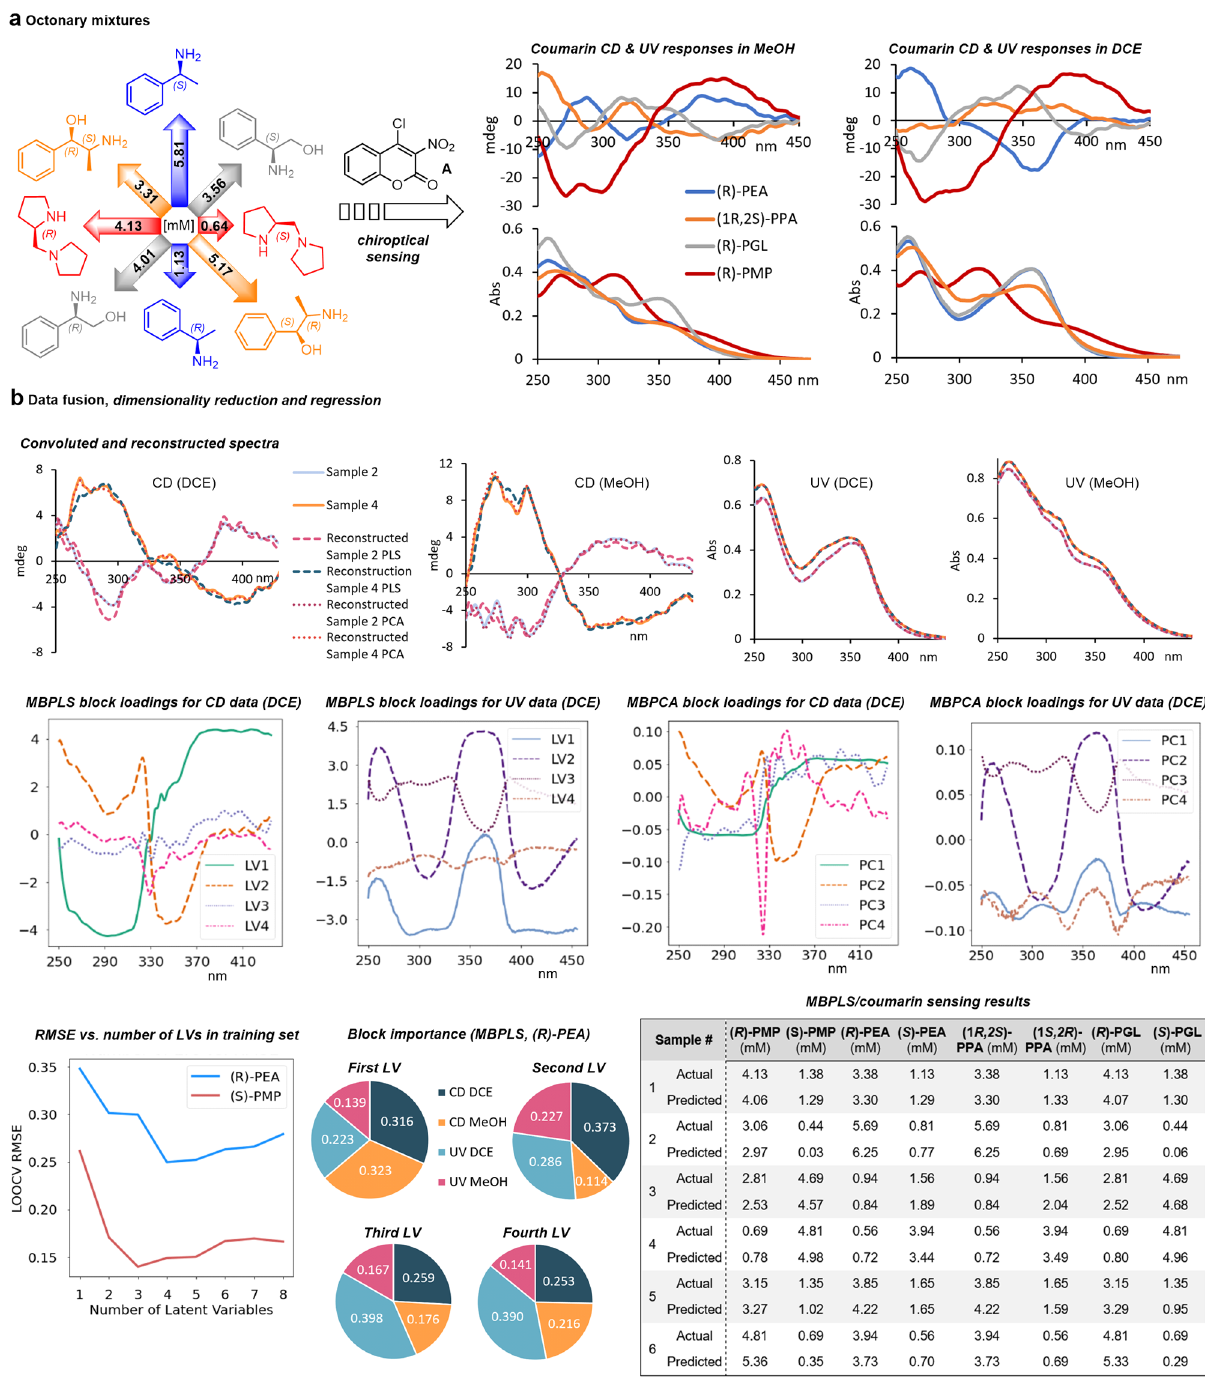
Fig. 5 Multi-modal optical chirality sensing of octonary samples. a Representation of a complex octonary chiral compound mixture and individual coumarin UV/CD responses for each chiral analyte in MeOH and DCE. b Top: The convoluted UV and CD spectra of fi ve samples were subjected to PCA and PLS analysis and the reconstituted spectra were generated using inverse transformation. Results with two samples are shown. Middle: Representative MBPCA and MBPLS block loadings for CD and UV spectra in DCE for ( R )- PEA . Bottom: Averaged LOOCV RMSE of the training sets vs. number of latent variables for ( R )- PEA and ( S )- PMP . The pie charts display the MBPLS block importance of 4 latent variables for ( R )- PEA . The table shows the comparison of the octonary sensing results obtained with MBPLS for six test samples and the actual concentrations. PEA : 1-phenylethylamine, PMP : 1-(pyrrolidin-2- ylmethyl)pyrrolidine, PGL : phenylglycinol, PPA : 2-amino-1-phenylpropan-1-ol. MBPCA multiblock principal component analysis, MBPLS multiblock partial least square, DCE dichloroethane, LOOCV leave-one-out cross-validation, RMSE root mean squared error, LV latent variable. The data underlying this fi gure are available as Source